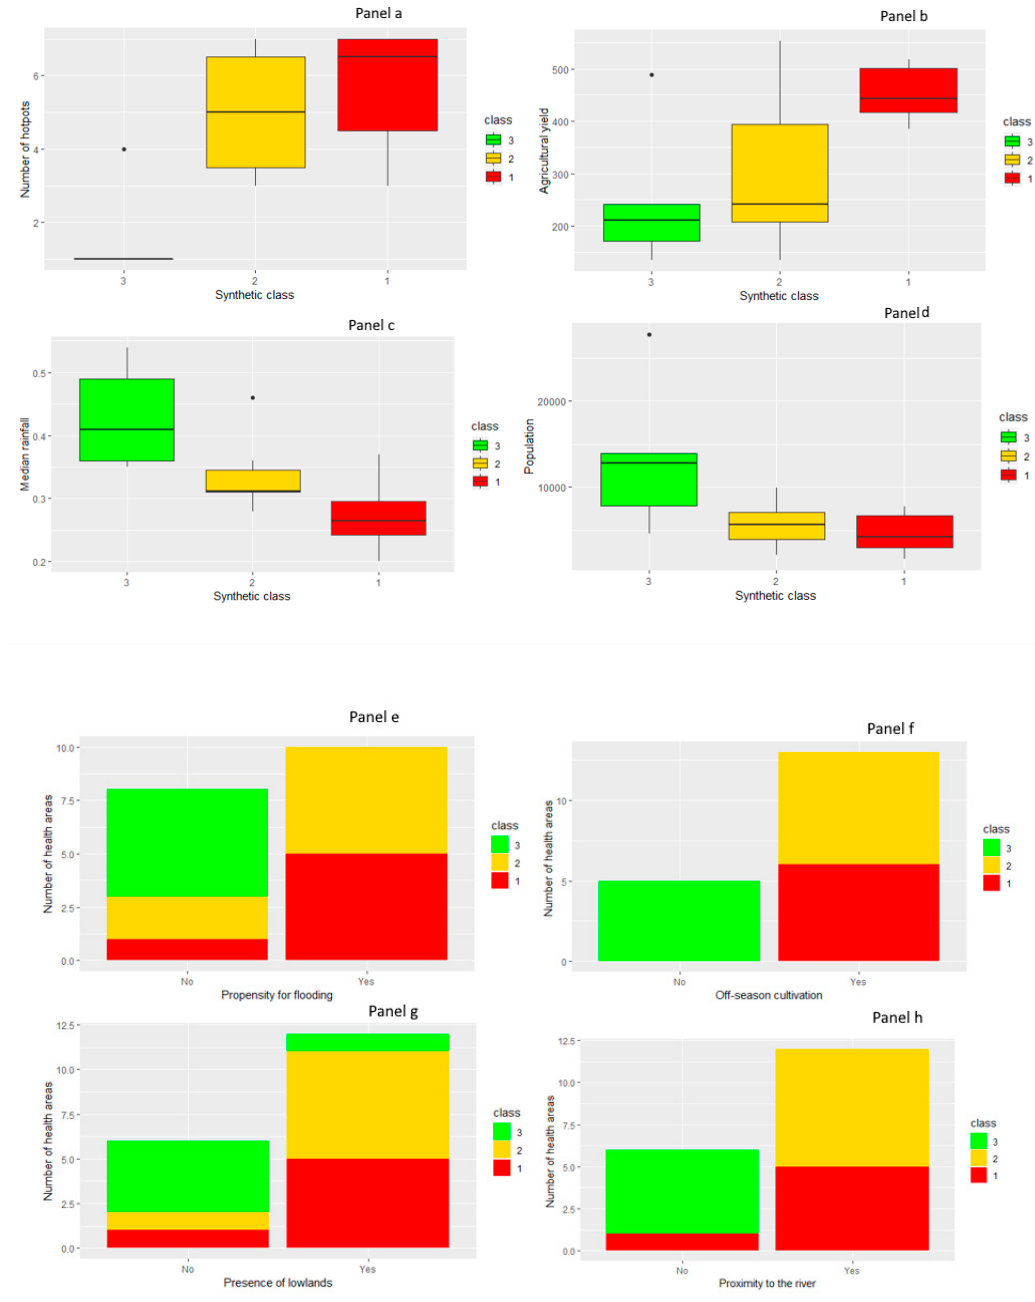
Figure 4. Relationship between risk classes and meteorological, and environmental variables, and risk classes. Panel ( a ) number of hotspot and risk classes, Panel ( b ) agricultural yield and risk classes, Panel ( c ) median rainfall and risk classes, Panel ( d ) population and risk classes; Relationship between environmental and meteorological variables and number of health areas at risk of being a hotspot. Panel ( e ) propensity for flooding and number of health areas at risk of being a hotspot. Panel ( f ) off-season cultivation and number of health areas at risk of being a hotspot. Panel ( g ) presence of lowlands and number of health areas at risk of being a hotspot. Panel ( h ) proximity to the river and number of health areas at risk of being a hotspot. Health areas showing the presence of these variables had a high risk of a being a hotspot.